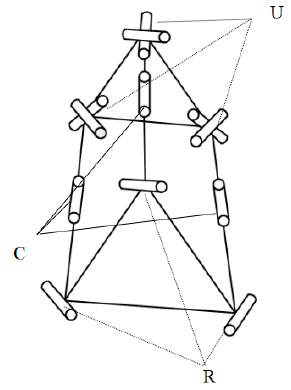
Figure 1. Structure diagram of micromanipulator platform.